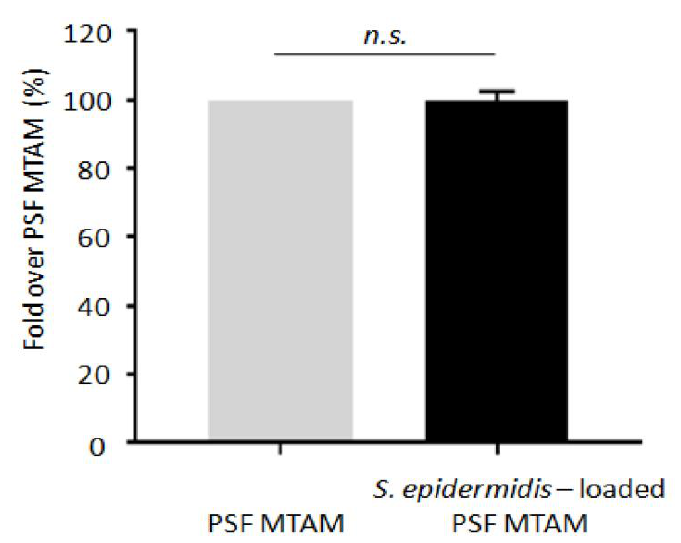
Figure 4. No bacterial leaking from S. epidermidis -loaded PSF MTAM. The ears of ICR mice were topically applied with PSF MTAM or S. epidermidis -loaded PSF MTAM. Three days after application, the number of S. epidermidis in ears was quantified by qRT-PCR. n.s. = non significant. (two-tailed